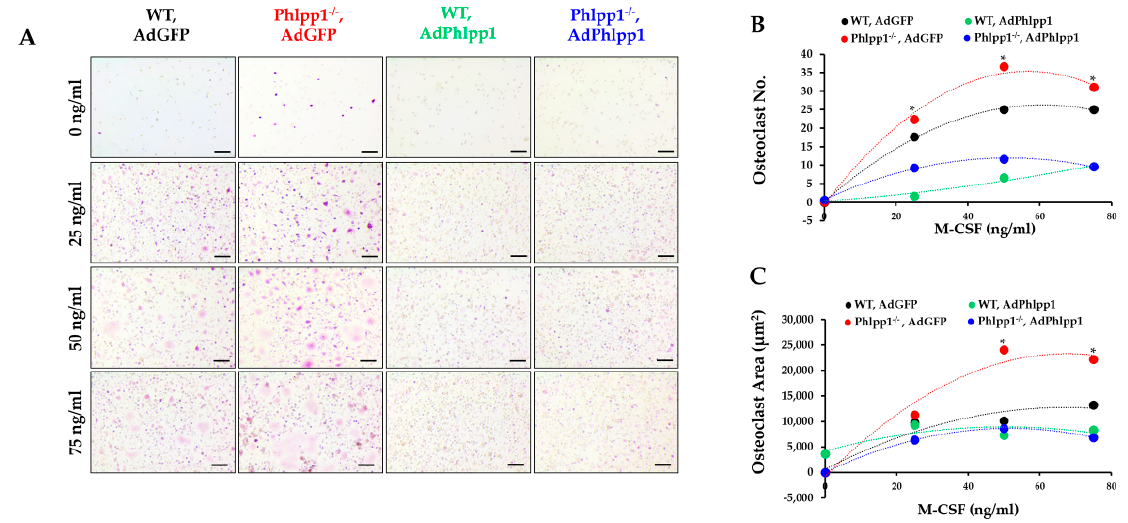
Figure 5. Phlpp1 attenuates responses to M-CSF. Osteoclasts were generated from bone marrow macrophages collected from 6–8-week-old Phlpp1 − / − females or their sex-matched WT controls. Cultures were infected with each indicated adenovirus (MOI = 10) on day 0 and samples were collected on day 4. ( A ) TRAP staining of cultures was performed and the ( B ) number of osteoclasts and ( C ) average osteoclast area per field was determined, * p < 0.05 Scale bars are 100 microns.